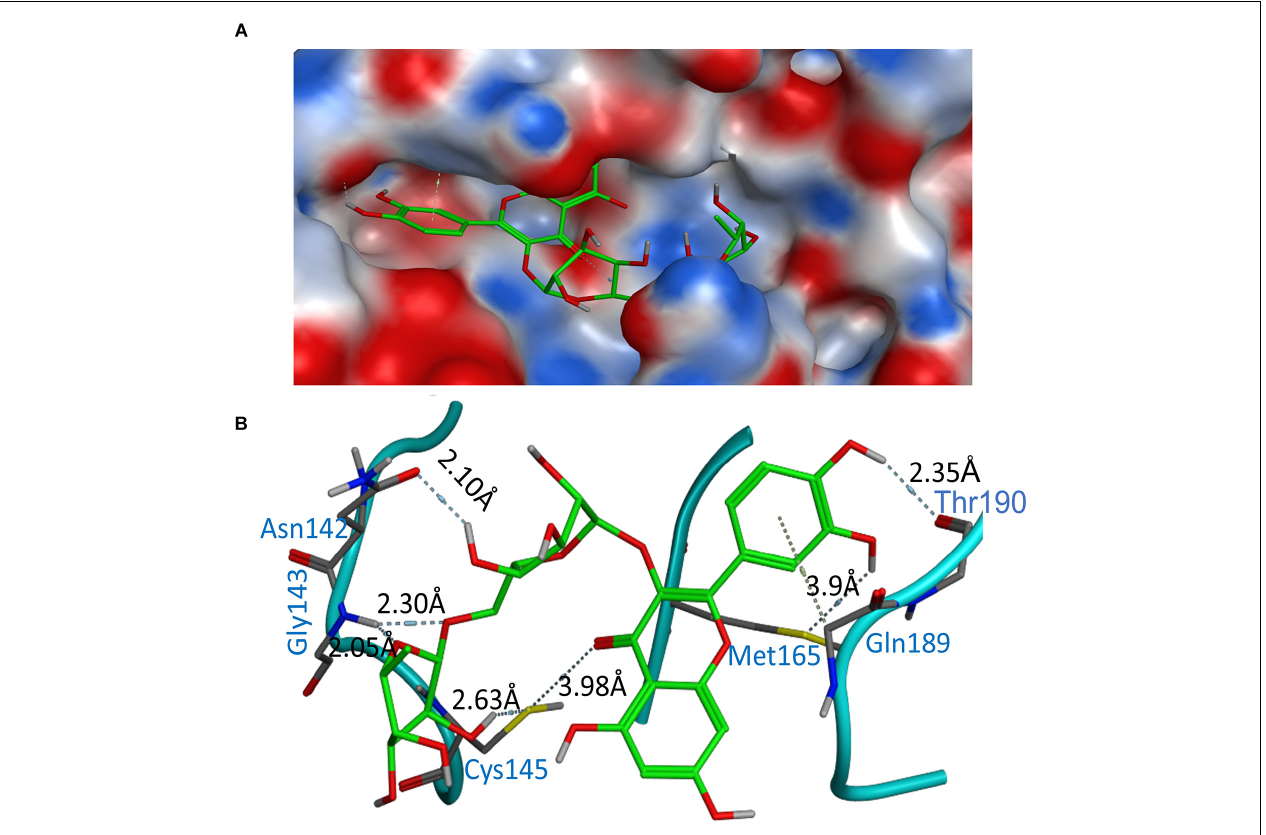
FIGURE 3 | Binding modes of Rutin with 6LU7. (A) Electrostatic interaction between Rutin and crystal structure (6LU7) of COVID-19 3CLpro. (B) Interactions between Rutin and associated residues in the crystal structure (6LU7) of COVID-19 3CLpro. Blue and gray labels shown in the figure are residue names and interaction distance